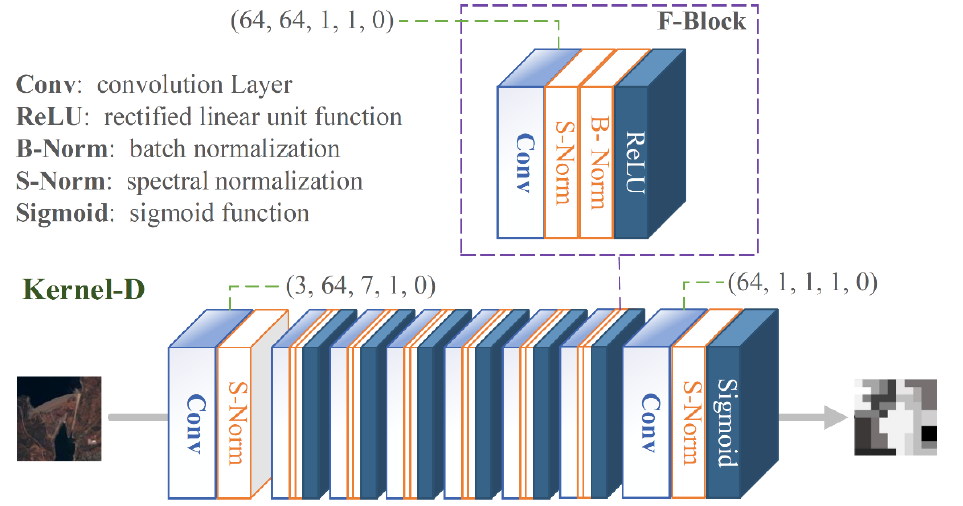
Figure 5. Discriminator network structure consisting of a multi-layer non-pooled convolution layer.